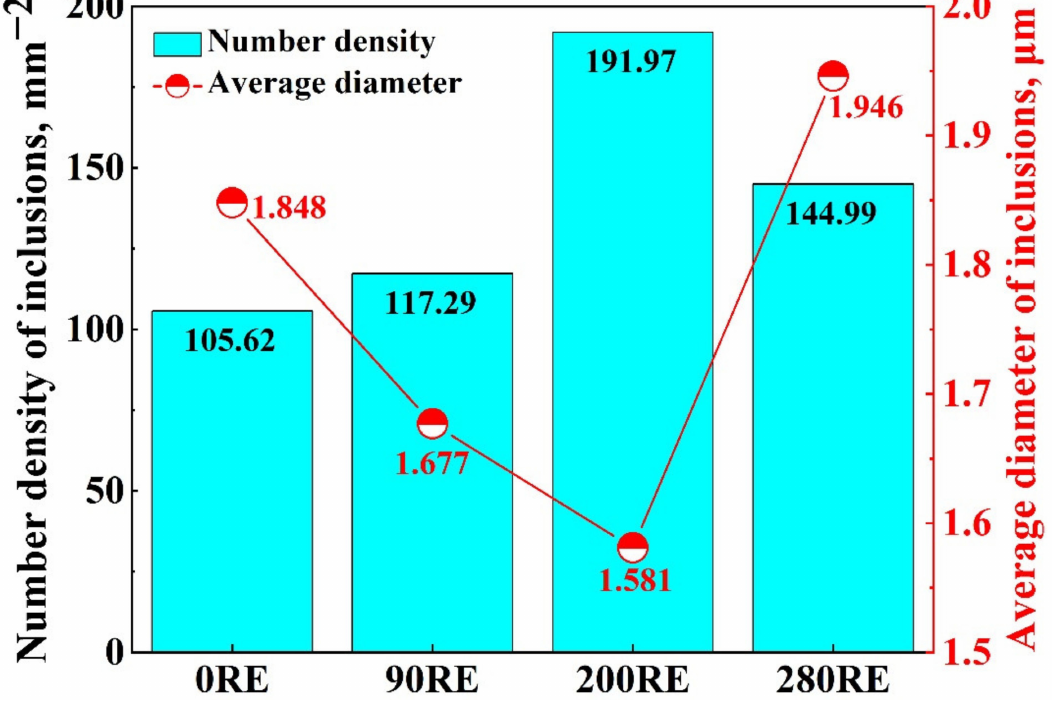
Figure 8. Comparison of the total number density and average diameter of inclusions with different rare earth